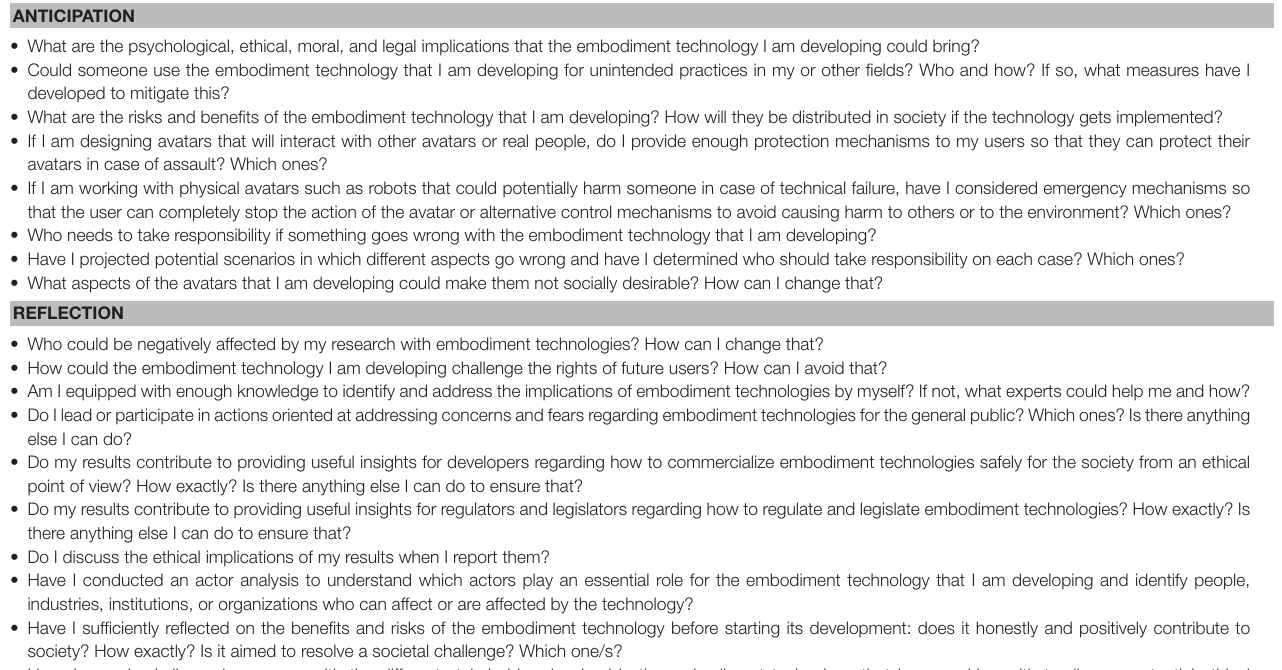
TABLE 1 | A self-guiding tool to conduct research with embodiment technologies responsibly.